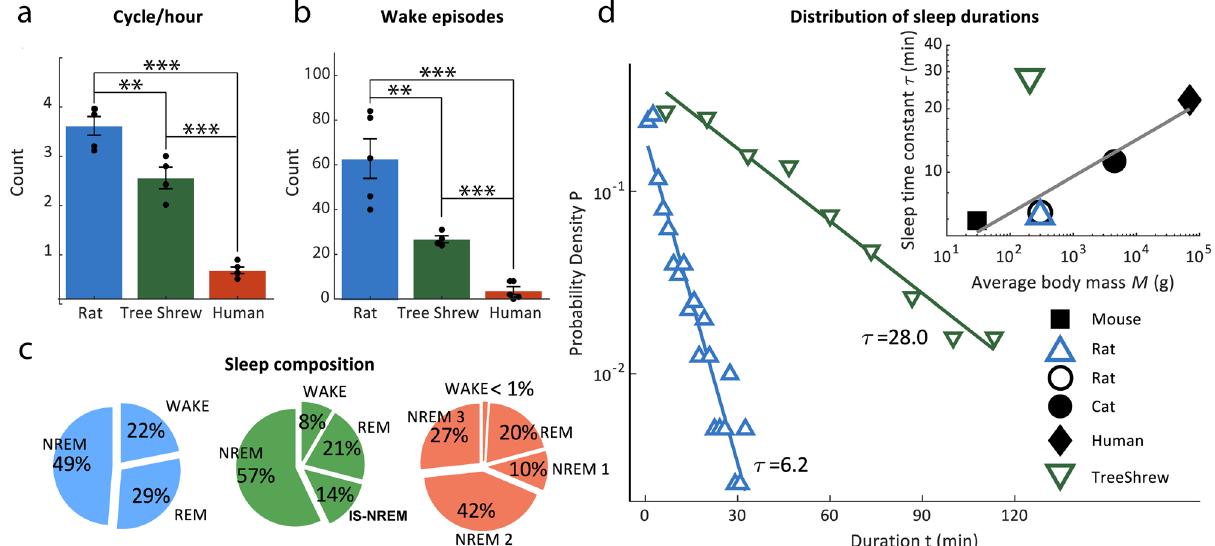
Fig. 4 Tree shrews have signi fi cantly longer and less fragmented sleep than rats. a Bar chart is showing average count of sleep cycles per hour across species, Rats n = 5, tree shrews n = 4, humans n = 5. Note, signi fi cantly more sleep cycles per hour in rats in comparison to tree shrews. b Bar plot is illustrating the mean count of wake bouts over the course of the recording period across species. Rats have signi fi cantly more wake episodes than tree shrews. c Pie charts showing the mean fractions of different behavioral stages after sleep onset in tree shrews, rats, and humans respectively. d Distributions of sleep bout durations for rats and tree shews. The data of both species follows a power law function with different time constants, τ . Lines between data points indicate the fi t of the function for tree shrew and rat in green and blue respectively. The inset shows values of the time constant τ for the distribution of sleep duration in relation to the body mass of different species. Human, mouse, rat, and cat data, black markers were taken from a previous publication 34 . Note that values obtained here for the rat match those of the previous study. Tree shrew and rat τ values are added based on our own data and analyses. Error bars re fl ect the standard error of the